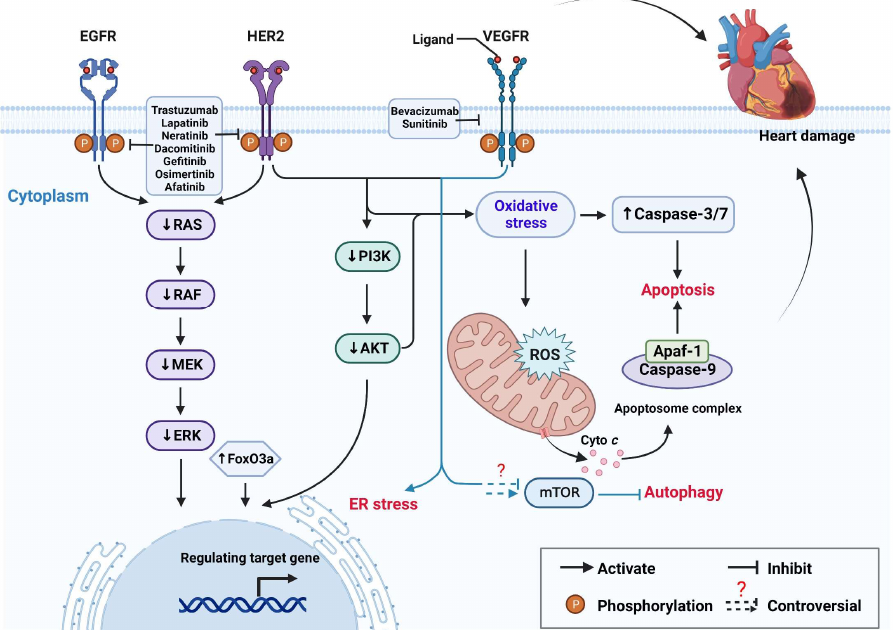
Figure 4. Mechanisms of cardiotoxicity induced by monoclonal antibodies/small molecule tyrosine pathways induces oxidative stress, ER stress, and apoptosis, ultimately causing cardiac injury. EGFR, epidermal growth factor receptor; HER2, human epidermal growth factor receptor 2; VEGFR, vascular endothelial growth factor receptor. Created with